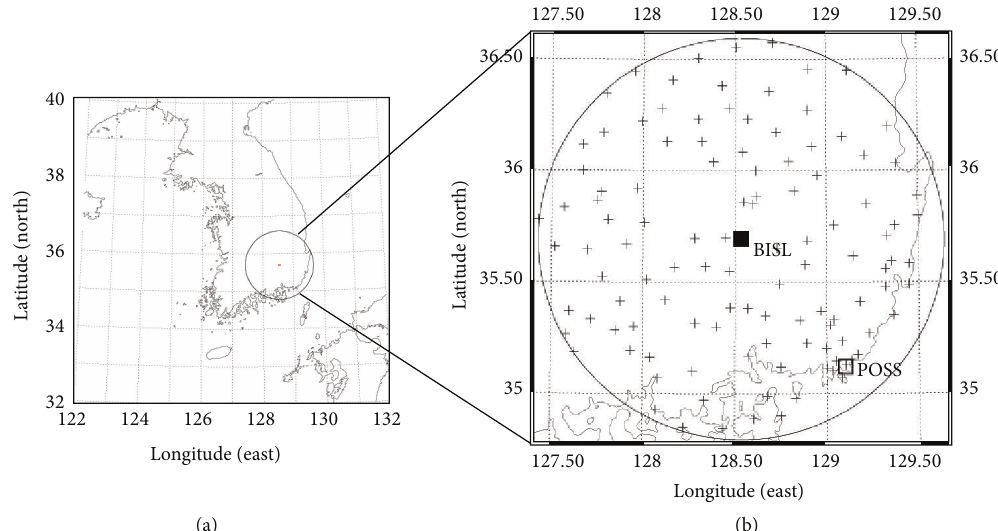
Figure 1: The location of the Bislsan radar (solid rectangle), the POSS disdrometer (open rectangle), and rain gages (plus signs) distributed within the area of radar coverage (100km